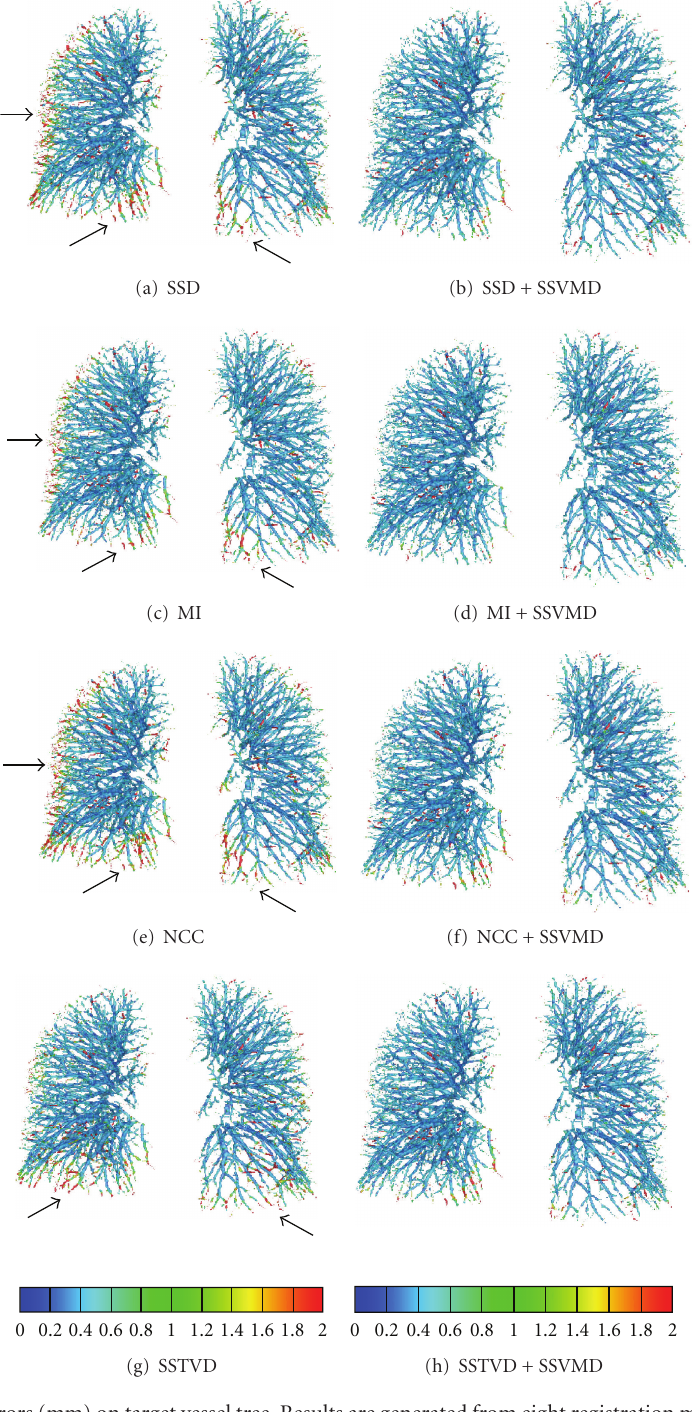
Figure 7: Vessel positioning errors (mm) on target vessel tree. Results are generated from eight registration methods. Arrows denote regions of large discrepancies between the deformed source and target vessel trees. Note that the errors in these regions were reduced after adding the SSVMD constraint to the registration